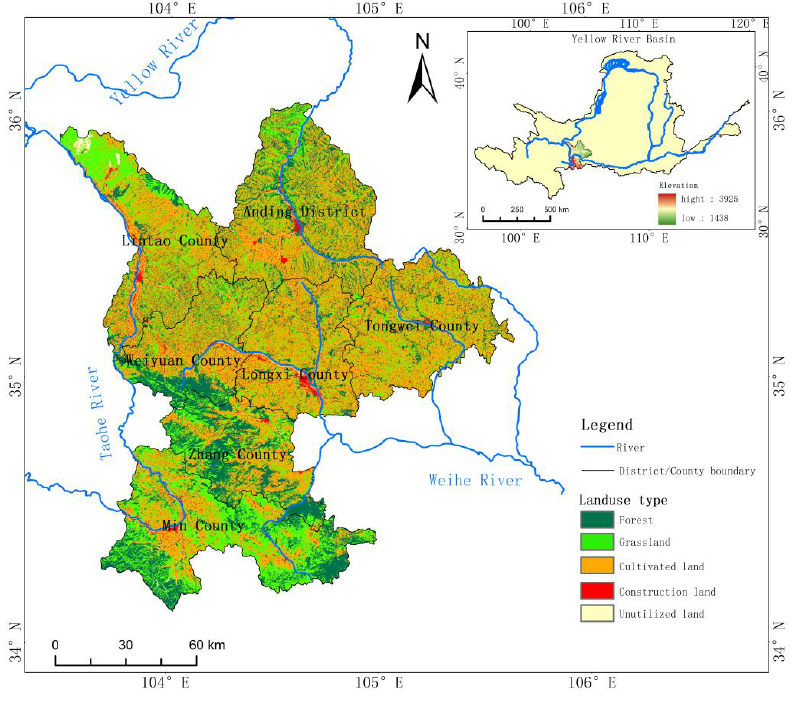
Figure 1. Location of Dingxi city.